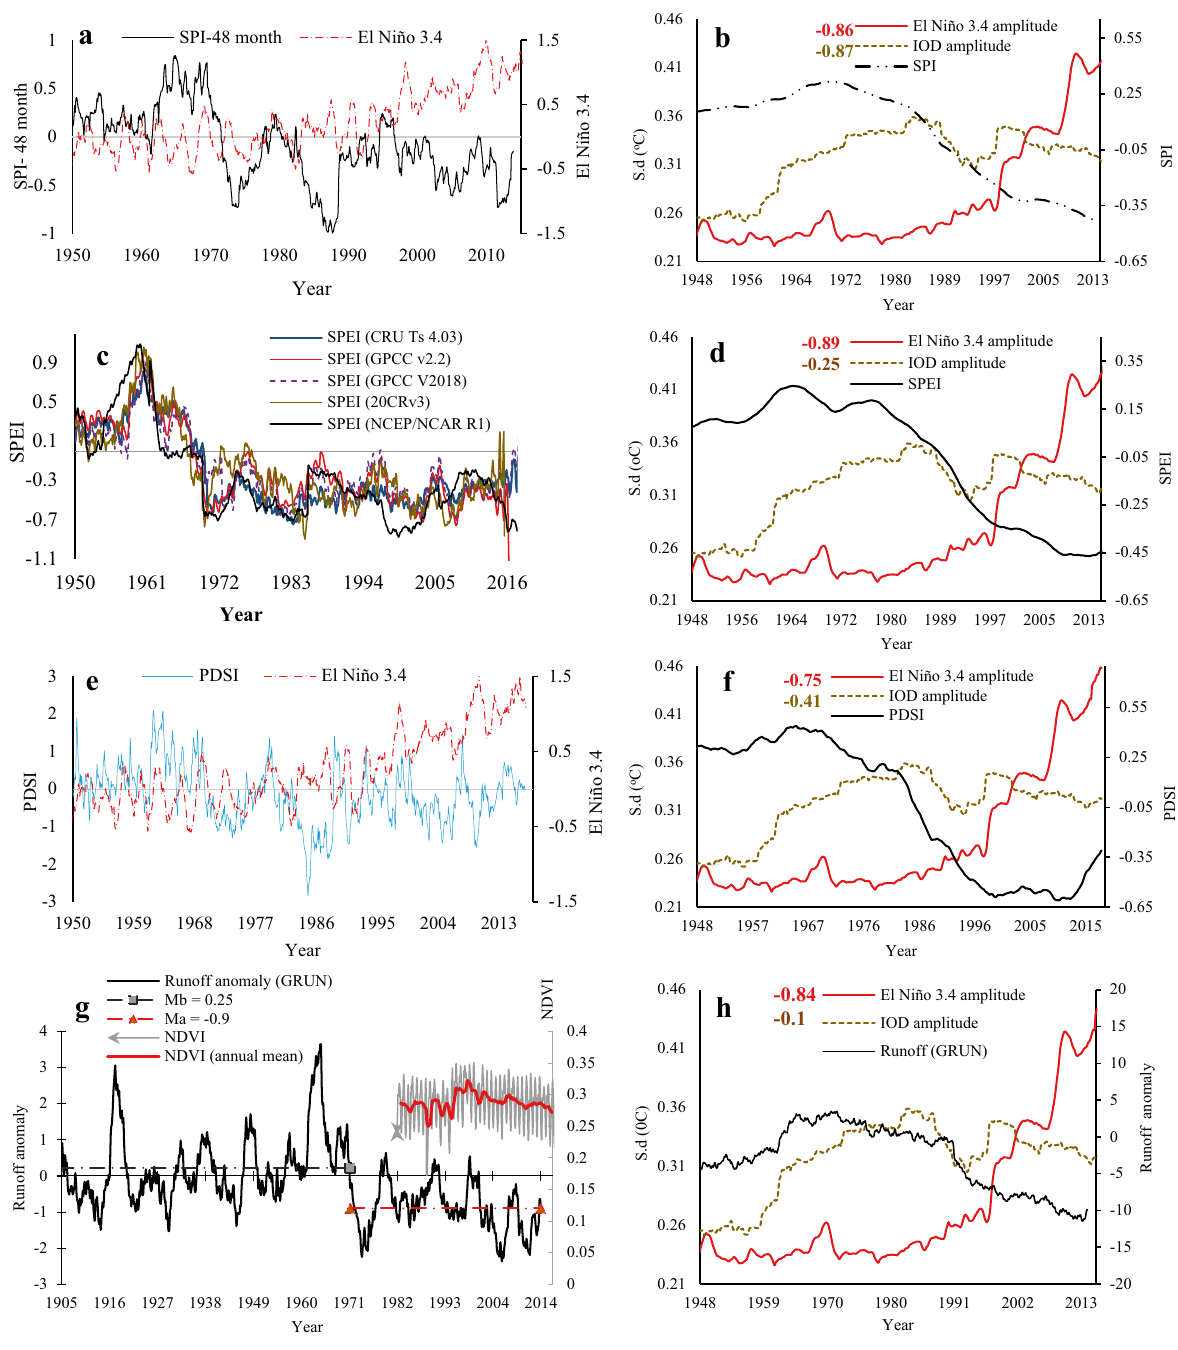
Figure 8. The influence of ENSO and IOD on drought conditions of NRB: ( a ) 48-month SPI versus El Niño 3.4, ( b ) IOD and El Niño 3.4 amplitudes correlations with SPI, ( c ) SPEI calculated using five precipitation data sets, all SPEI indices show a statistically significant drying trend ( p < 0.05) since the 1970s. ( d ) IOD and El Niño 3.4 amplitudes correlations with SPEI, ( e ) sc-PDSI versus El Niño 3.4, ( f ) IOD and El Niño 3.4 amplitudes correlations with sc-PDSI, ( g ) trend and variability of monthly runoff anomaly averaged over a 3-year moving window between 1902 and 2014 using GRUN- Runoff observation-based global gridded runoff. The right-hand side of Fig. 8g shows the monthly Normalized Difference Vegetation Index (NDVI) computed from NOAA Climate Data Record (CDR) of AVHRR NDVI V5 and averaged over the entire Nile River basin. ( h ) IOD and El Niño 3.4 amplitudes correlations with runoff anomaly. In ( b , d , f , h ) the SPI, SPEI, sc-PDSI, runoff indices were computed over 20-year running periods from 1920 to 2017, El Niño 3.4 and IOD amplitude are the SD of El Niño 3.4 and IOD indexes over 20-year windows from 1920 to 2017 using the ERSST data sets. The numbers in the top right of ( b , d , f , and h ) are the detrended cross-correlation coefficient between drought indices and IOD amplitude (brown colour) and El Niño 3.4 amplitude (red colour) at the 5%